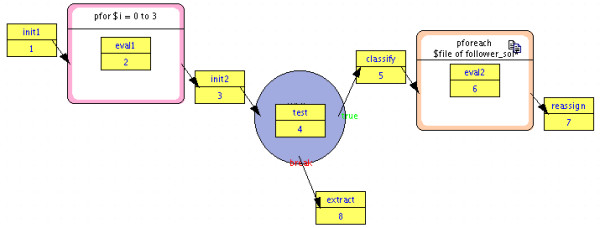
Swarm optimisation example. Component eval1 is executed four times in parallel within a parallel for loop. The circle denotes a while loop, with test as loop guard: if test returns false, then we follow the bottom branch to extract, otherwise we follow the right branch and test test again after reassign. Component eval2 is executed in parallel once for each file matching follower_sol*.